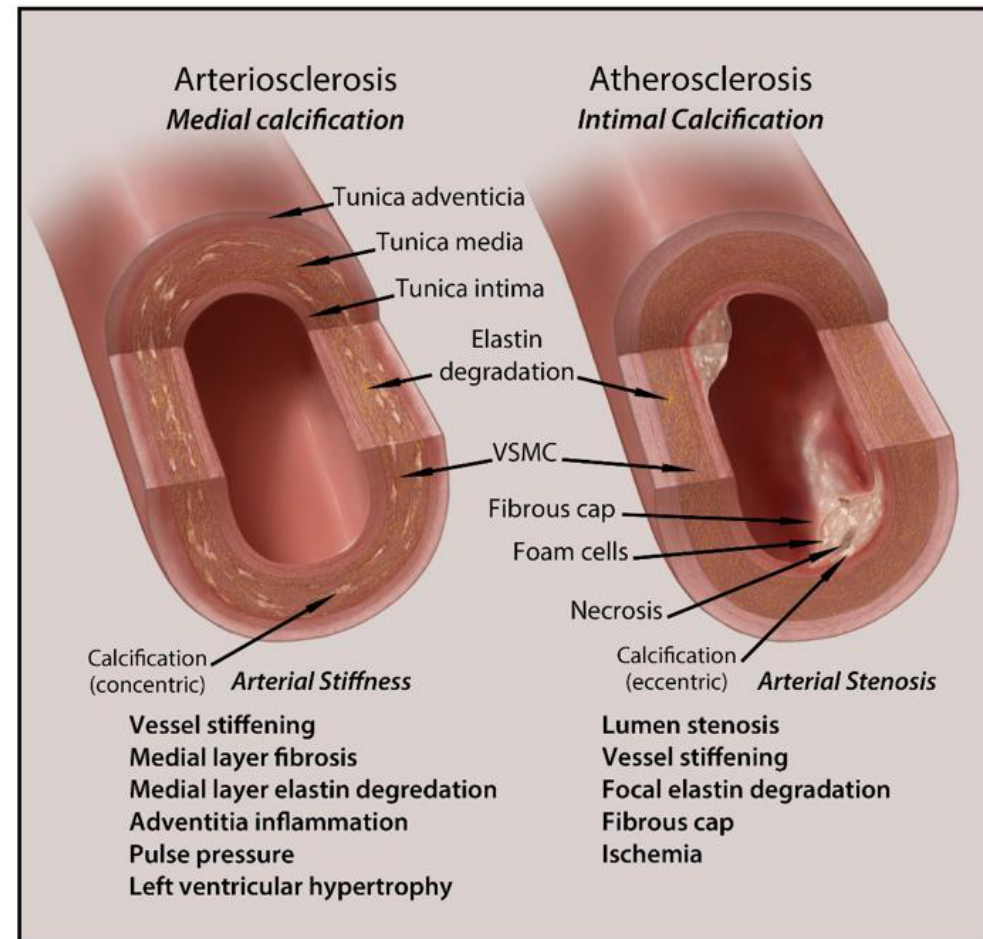
Figure 2. Schematic representation of intimal and medial calcification and their related